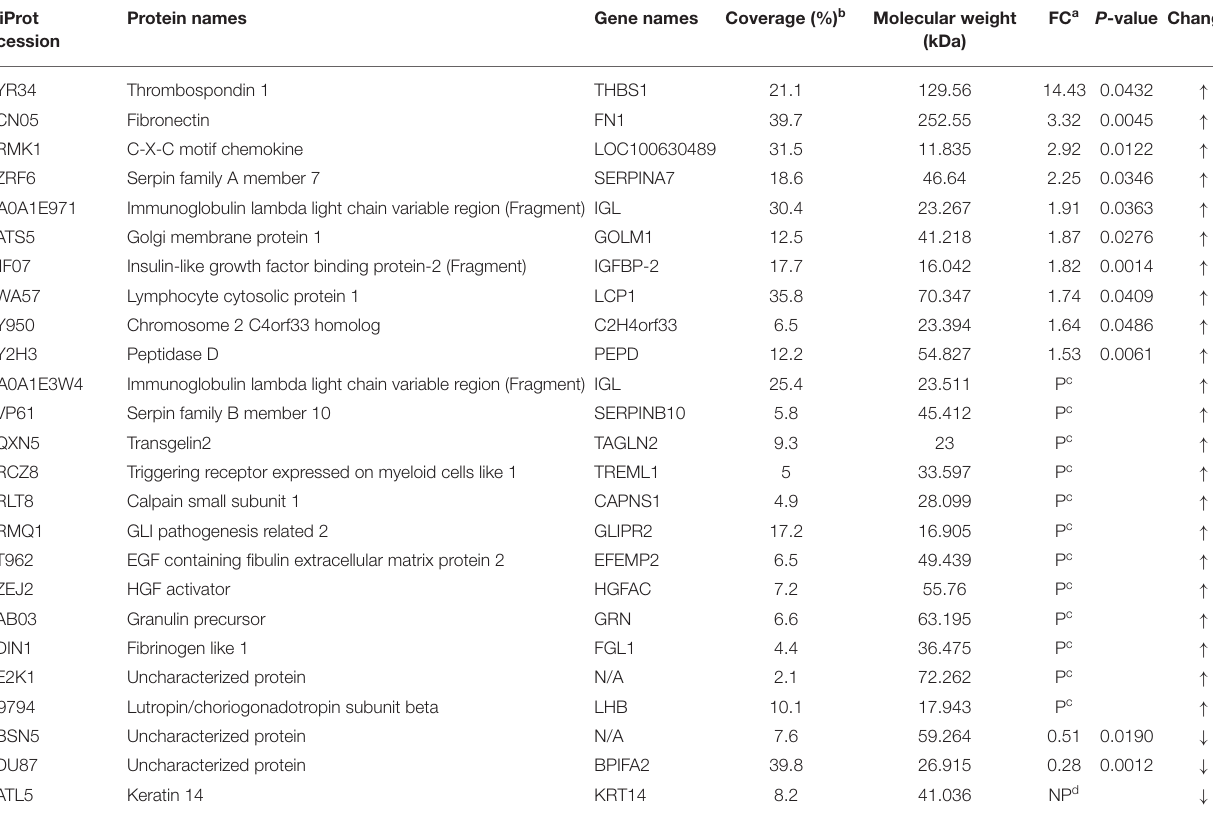
TABLE 1 | Differentially expressed proteins in the serum of early pregnant (P group) and non-pregnant (NP group) jennies. UniProt